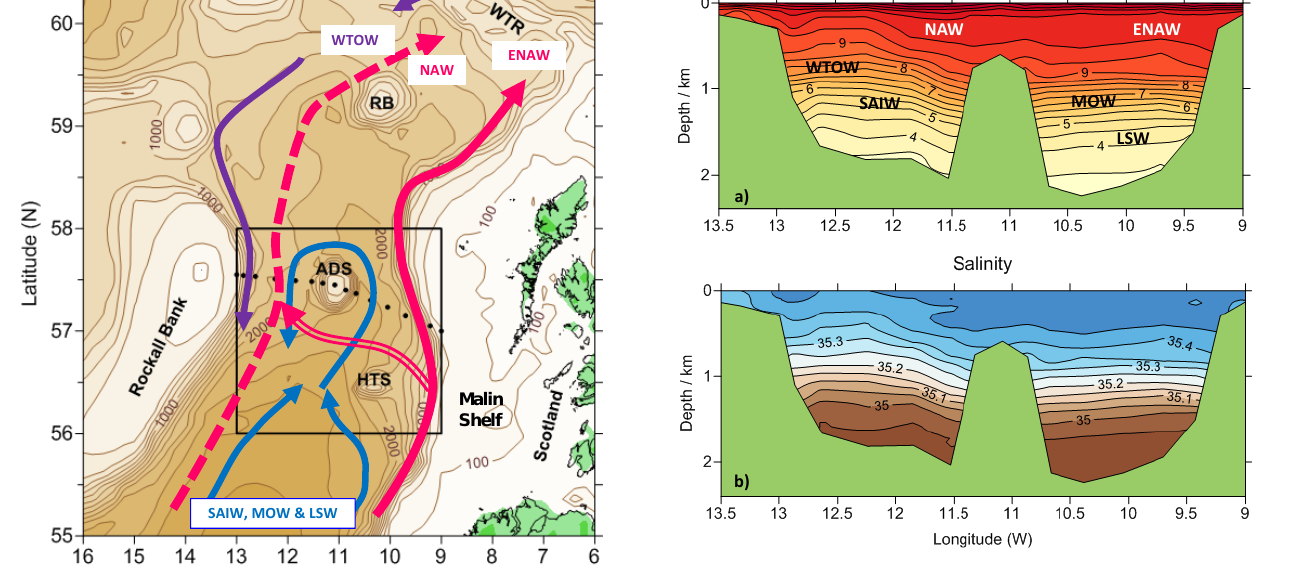
Figure 2. (a) Temperature and (b) salinity sections through the An- ton Dohrn Seamount in mid-June 2009. Water masses are indicated, with those in black being much diluted at 56 ◦ N. Kriging interpo- lation was used to map contours to the seabed. The approximate bathymetry is defined by the depth of each